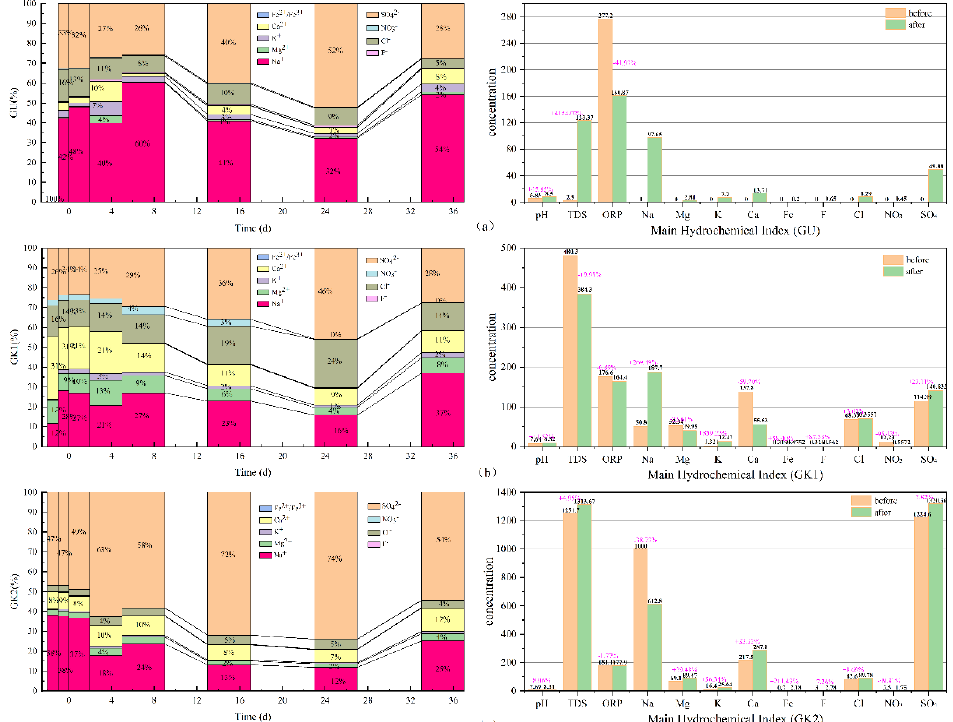
Figure 6. The main hydrochemical ions variation relationship diagram throughout the experiment and the difference from beginning to end. (( a ) Graph of the proportion change of water chemical ions in GU immersion solution and the difference in the data; ( b ) Graph of the proportion change of water chemical ions in GK1 immersion solution and the difference in the data; ( c ) Graph of the proportion change of water chemical ions in GK2 immersion solution and the difference in the data) After the water – rock reaction, the mine water quality type changes, and the water quality type changes as shown below (Figure 7 and Table 2).